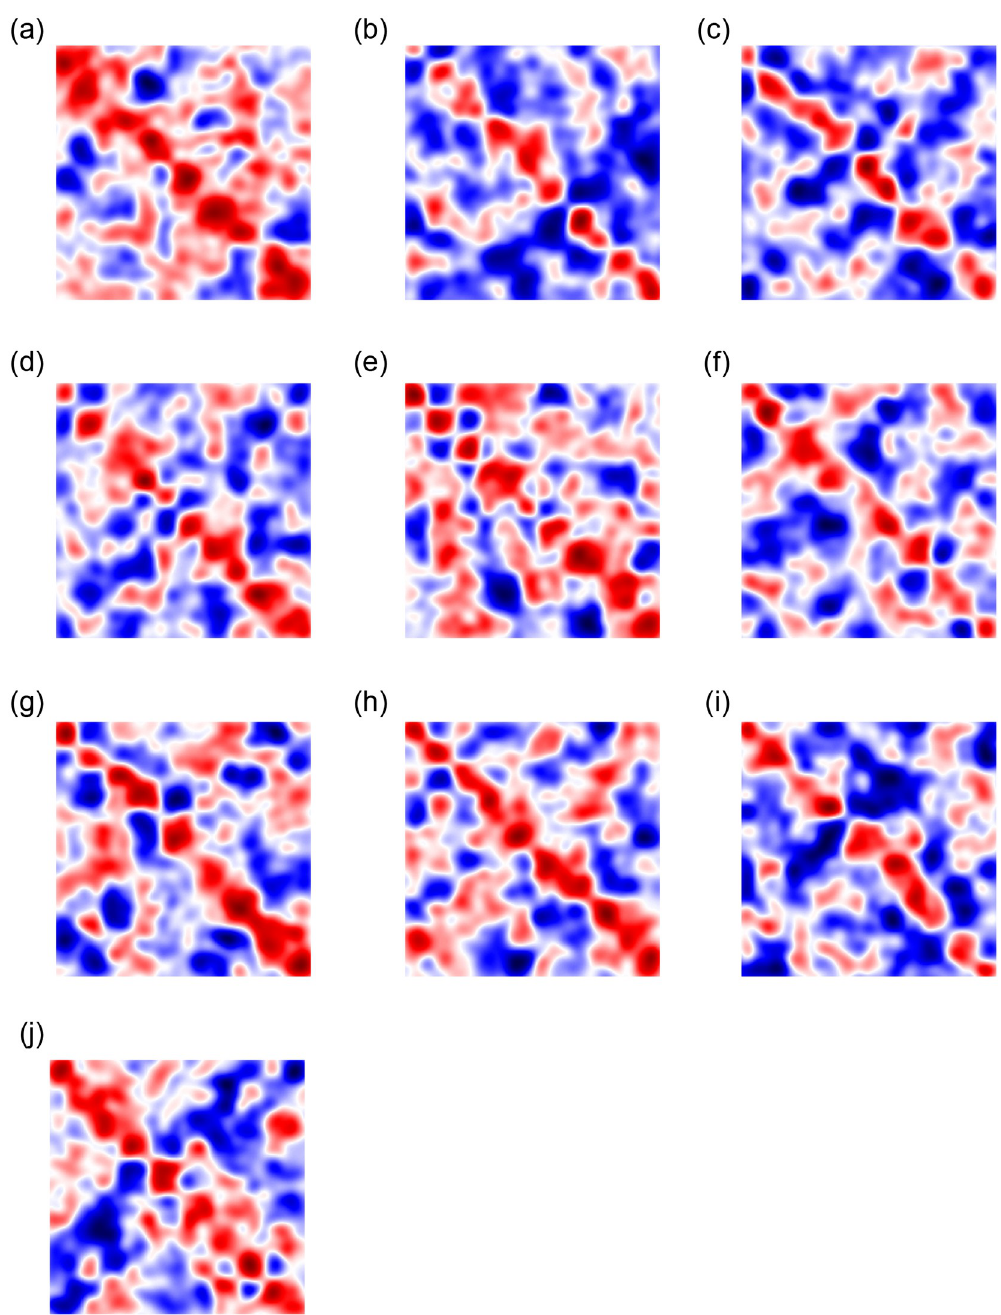
Fig 4. Heatmaps of the relation matrices learned with TuckER for each income decile. Red and blue colors indicate high and low-value entries in the relation matrices, respectively. These matrices are computed using k -mode tensor products between R and the second mode of the core tensor W . Although the model does not force the learning of symmetric relationships, all the learned relationships are approximately symmetric, indicating a good fit of the model to SA19k.